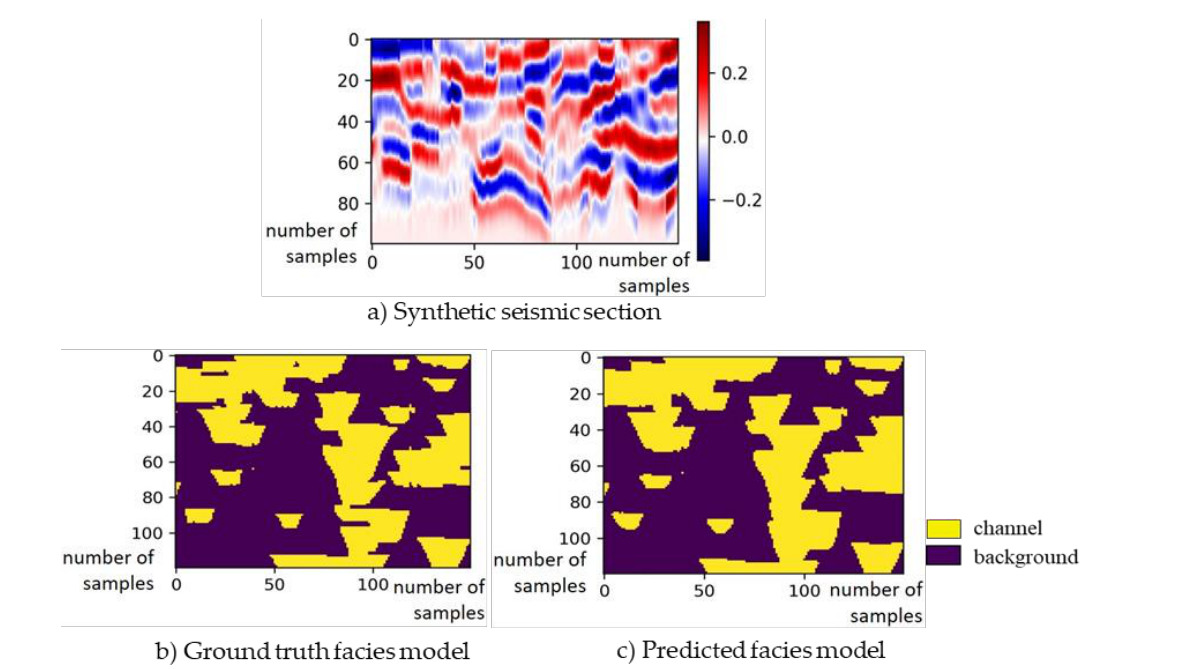
of 0.95 was obtained, which is the best among all three models. The result is shown in Figure 23.